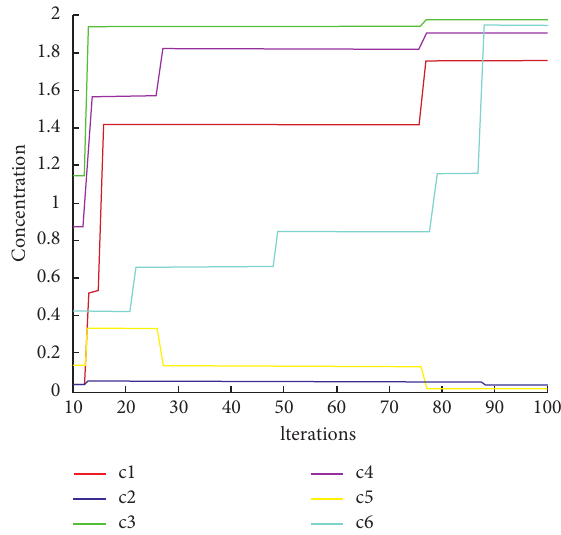
Figure 7: Performances of concentrations vs iterations.